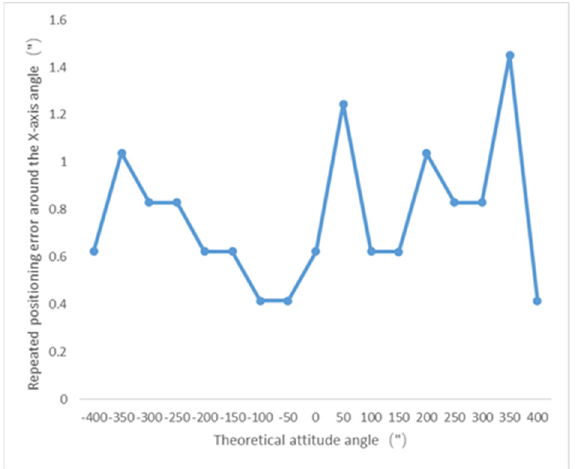
Figure 18. Repeat the positioning error of attitude angle at each position point.